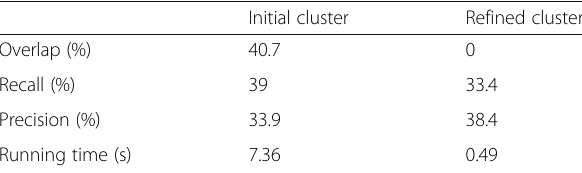
Table 1 Average performances of the initial and refined clusters with Tabu Search